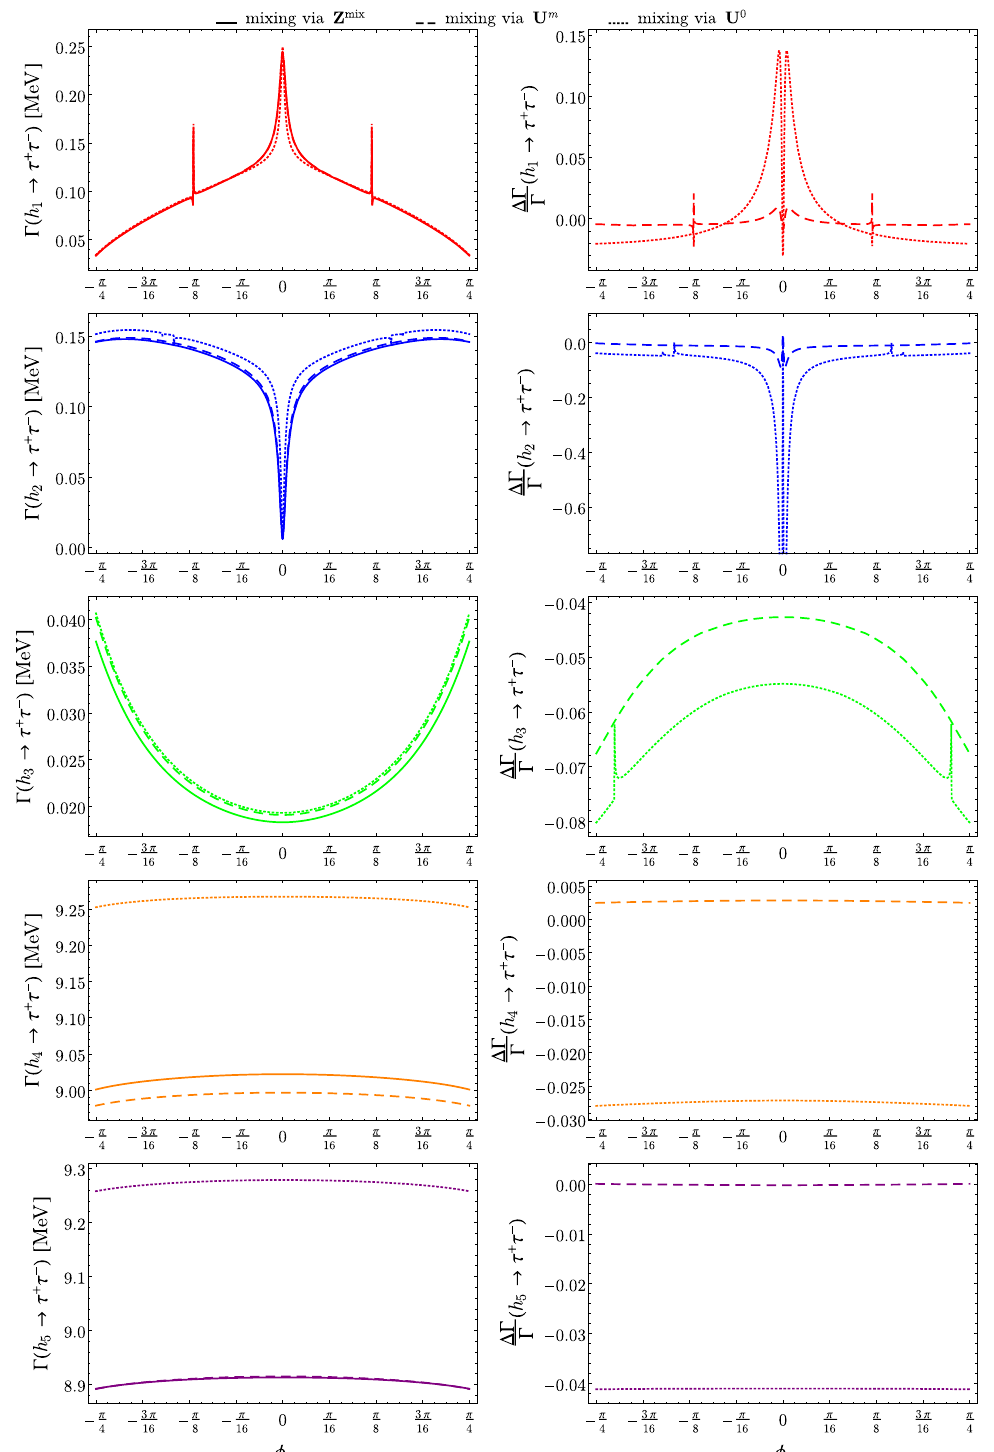
Fig. 11 In the left column , we show the decay widths (cid:17)( h i → τ + τ − ) in the scenario of Fig. 10 for the five neutral Higgs states. The widths are computed at the one-loop level, and the mixing of the external, physical Higgs fields is expressed in terms of the matrix Z mix ( solid ), or